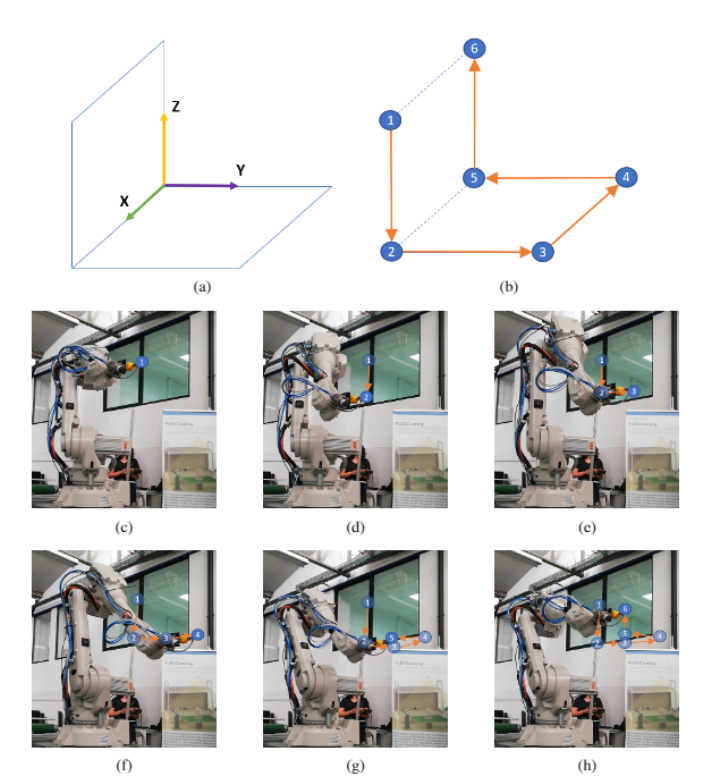
Figure 10. ABB IRB 2600 path execution (3D solid): ( a ) path referential frame. ( b ) Path sequence. ( c ) Robot at initial point. ( d ) Robot at second point. ( e ) Robot at third point. ( f ) Robot at fourth point. ( g ) Robot at fifth point. ( h ) Robot at final